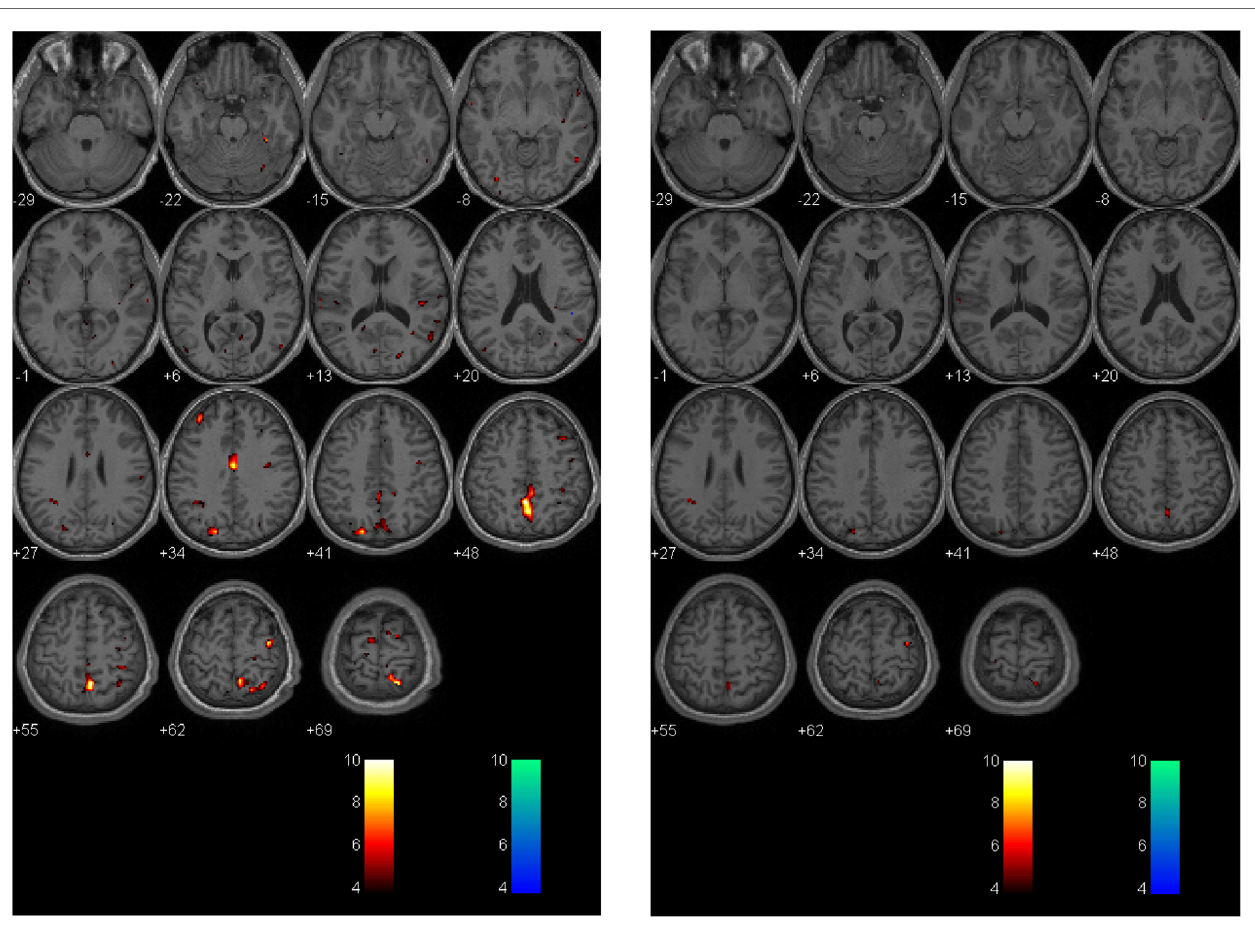
FiGUre 6 | Longitudinal assessment of adolescent postconcussion syndrome patient . Symptomatic adolescent PCS patient imaged following abnormal formal neuropsychological testing and symptom-limiting threshold on graded aerobic treadmill testing 3 months post-injury [left panel; image reproduced with permission from Journal of Neurosurgery [Mutch et al. (17)]. Patient re-imaged 5 months later following treatment with sub-maximal exercise prescription resulting in symptom, neuropsychological, and physiological recovery (right panel). The p -value is 0.005 as in Figures 4 and 5